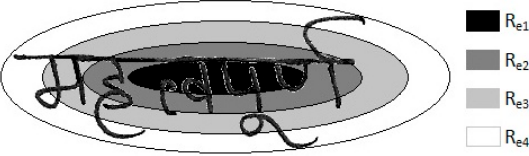
Figure 3. Figure showing the elliptical partition of four regions on a sample handwritten Devanagari word image.